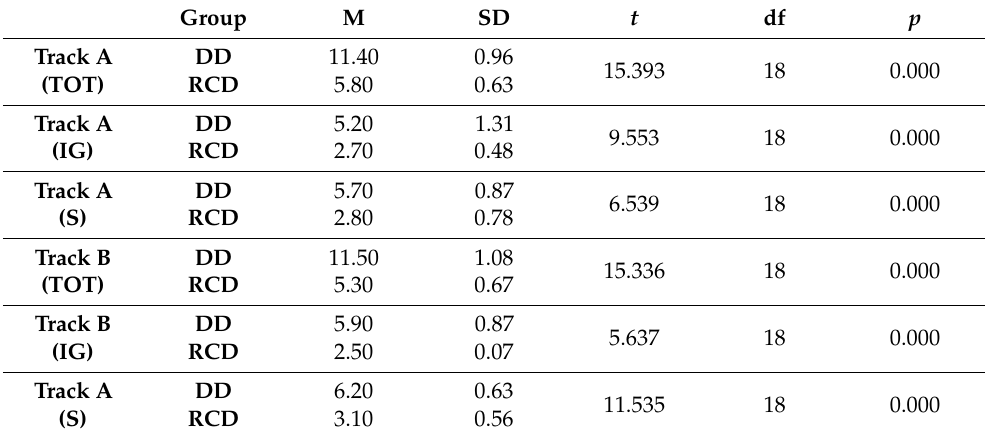
Table 2. Mean differences in LSC-SUA: comparison between groups in Tracks A and B. Group M SD t df p Track A